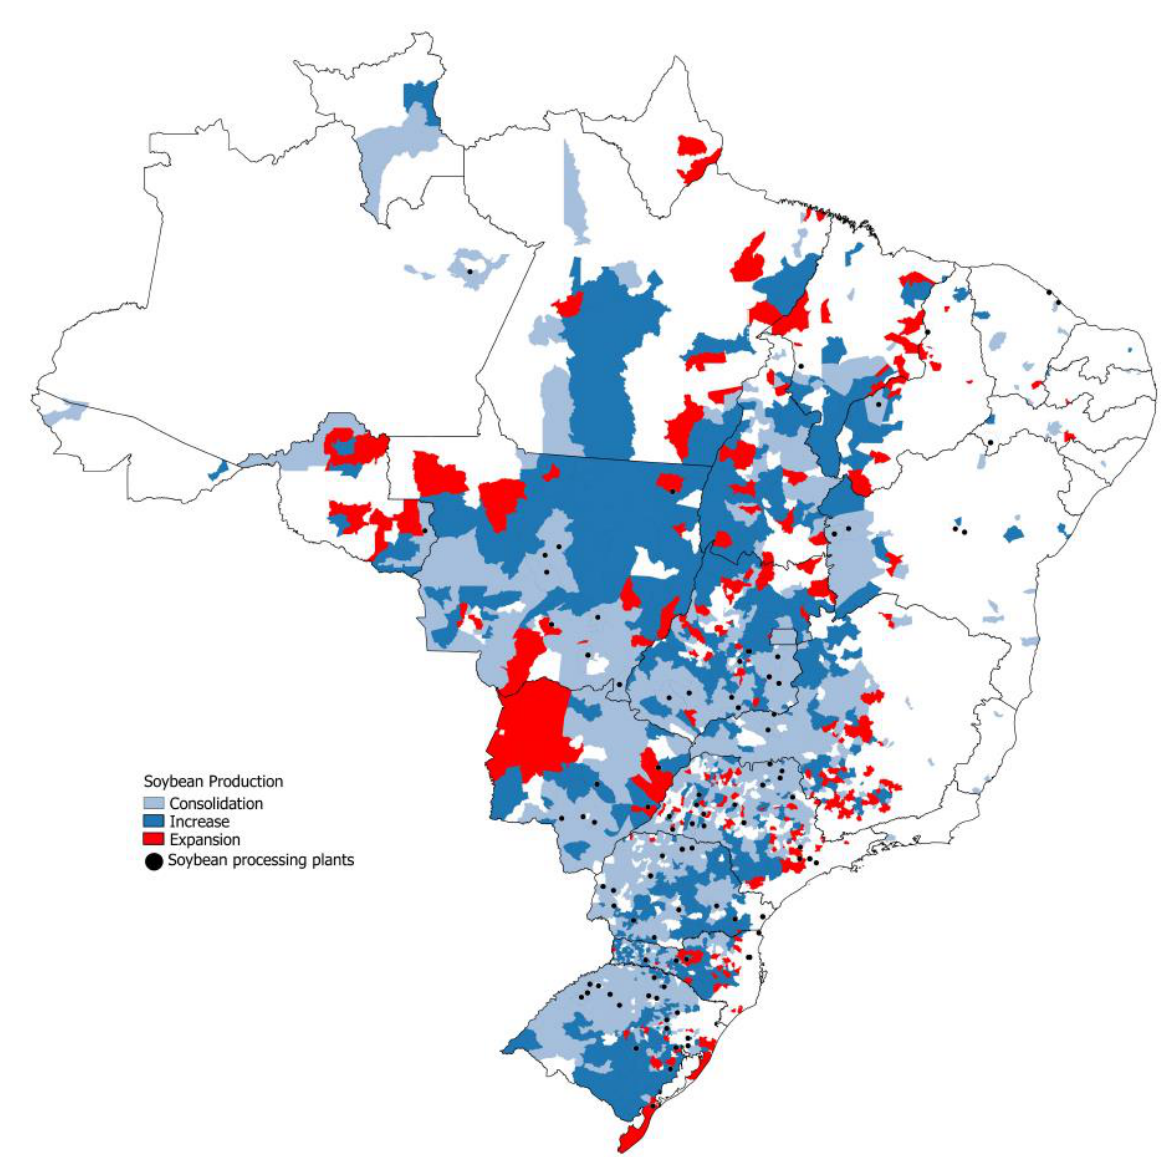
Figure 1. Consolidation and expansion of soy plantations in Brazil between 2006 and 2017. Consolidation is defined as municipalities that have remained as important producers and that have increased their planted areas, when comparing data from 2017 with 2006. Expansion is defined as municipalities planted with soy in 2017 that did not previously have soy planted in 2006. Source: Based on the data of the area planted with soybeans in 2006 and 2017, which are available at the Brazilian Institute for Geography and Statistics website (SIDRA/IBGE). 2017 is the year of the latest agricultural census in Brazil.